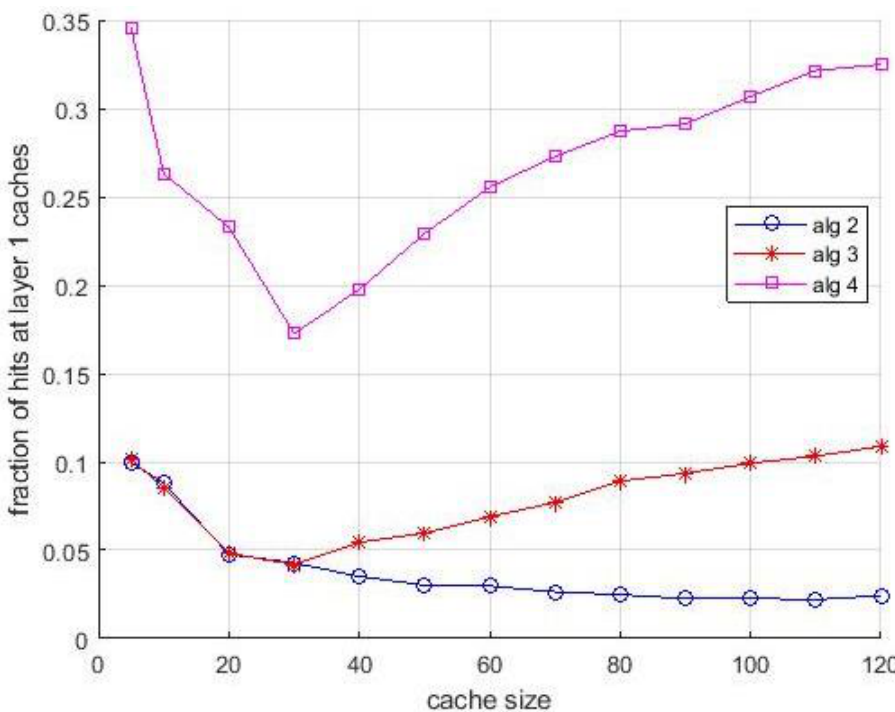
Figure 14. Fraction of hits at 1st layer caches, case 4, N = 2000.